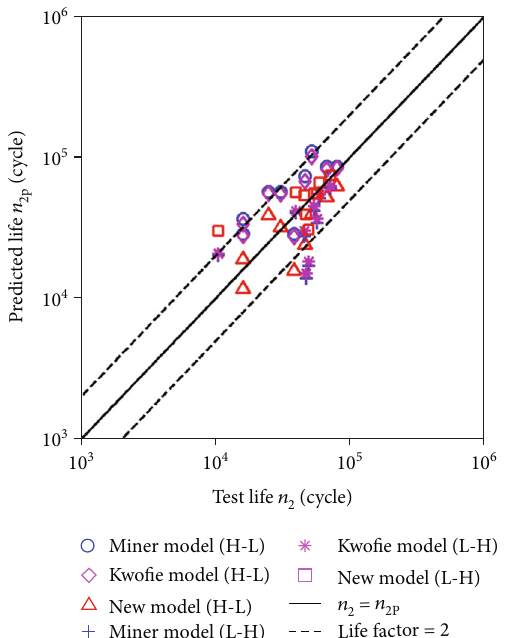
Figure 9: Comparison of theoretically predicted and experimentally obtained remaining lives of the Ti-6Al-4V titanium